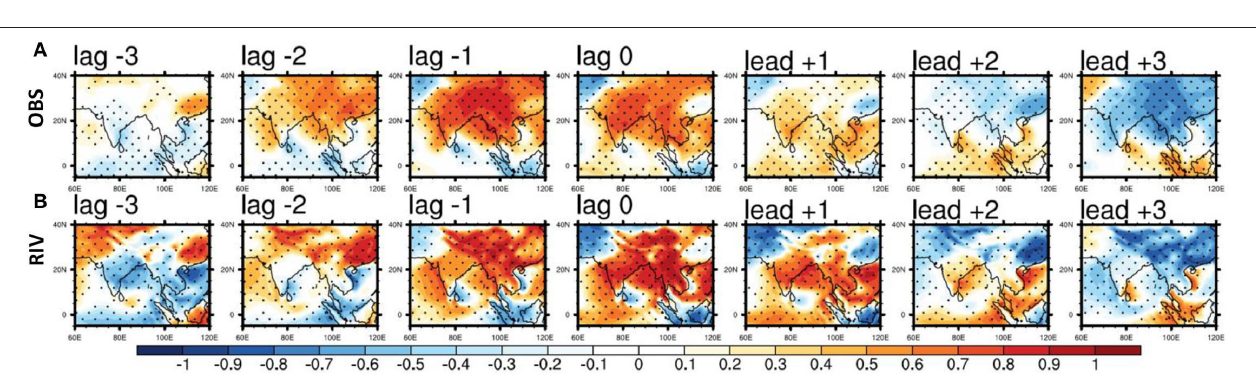
FIGURE 9 | Lag correlation of monthly rainfall with Ganga-Brahmaputra discharge for (A) observations and (B) RIV model simulation. Rainfall time-series leads/lags to discharge with a monthly lag frequency. Correlation values significant at 90% confidence level are stippled.